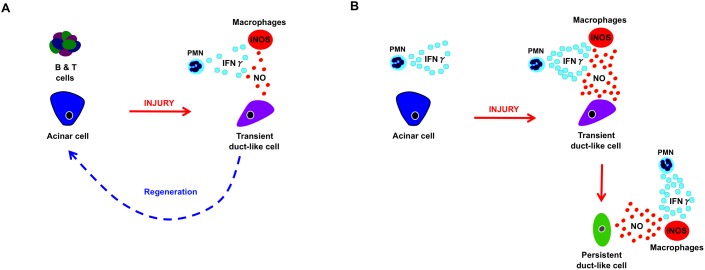
Inflammatory factors that influence effective versus ineffective pancreatic regeneration.Schematic depicting the impact increased innate inflammation has on exocrine de-differentiation and regeneration in (A) the presence (WT mice) and absence (B) of adaptive immune cells (Rag1−/− mice).